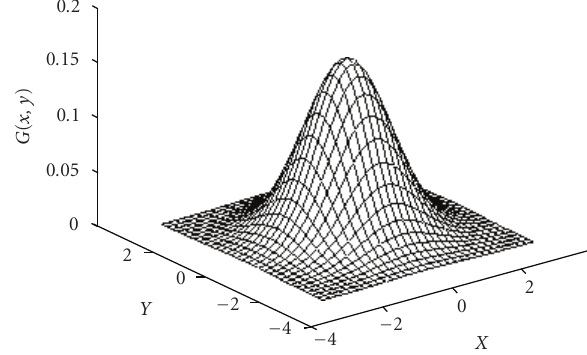
Figure 3.1. 2D Gaussian distribution with mean (0,0) and σ = 1 (Source: http://www.cee.hw.ac.uk/ hipr/html/gsmooth.html.)